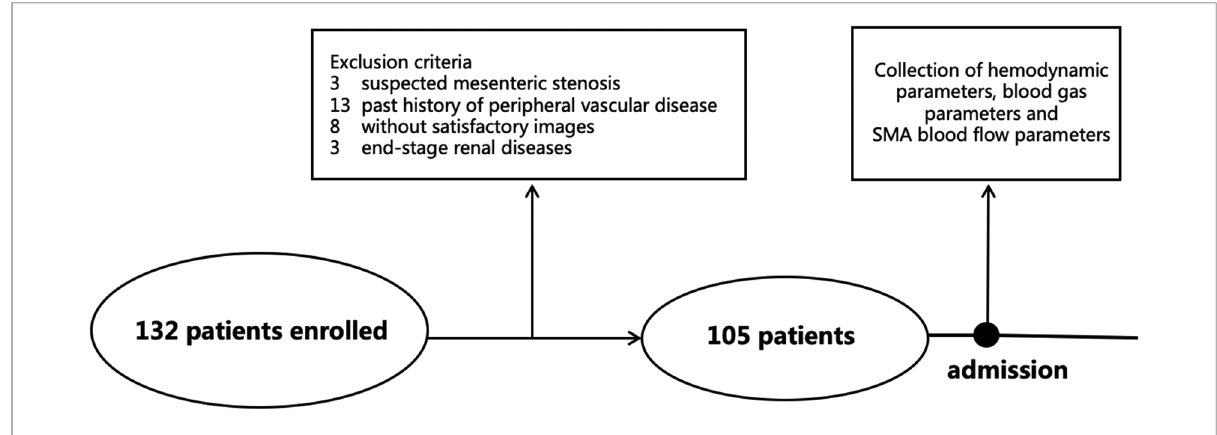
FIGURE 1 Protocol of the study. SMA, superior mesenteric